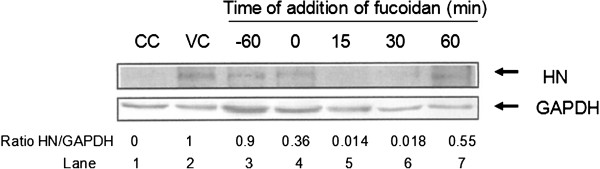
NDV HN protein levels in Vero cells infected with NDV and treated with fucoidan. Vero cells (3 × 105) were infected with NDV and treated with 100 μg/mL fucoidan at different times of infection. Lane 1, cellular control without NDV infection (CC); Lane 2, viral control without fucoidan treatment (VC), Lanes 3–7, cells infected with NDV and treated with fucoidan at 60 min before and 0, 15, 30, and 60 min after infection, respectively. Cells lysates were prepared, and equal amounts of protein extracts (40 μg) were subjected to immunoblot analysis to detect HN and GAPDH levels. The ratio of HN/GAPDH expression in the immunoblot analysis was quantified using Phoretix1D v2003.02 software.